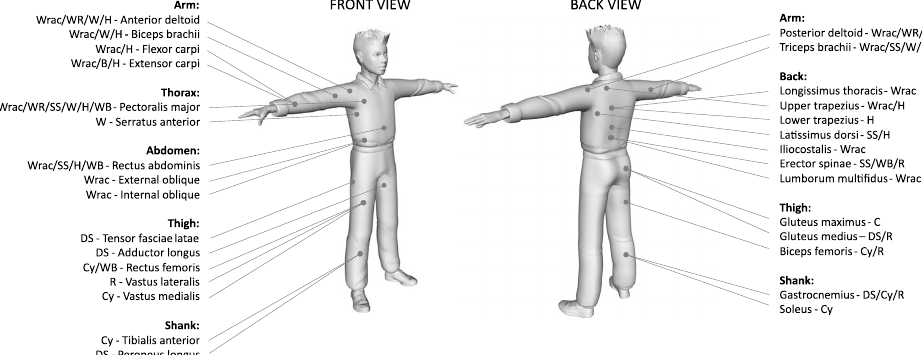
Figure 5. Positioning of EMG sensors with the specific muscle and related sport. Wrac = Wheelchair racing [47,53,54,67]; WR = Wheelchair rugby [51]; WB = Wheelchair basketball [71]; DS = Downhill skiing [74]; Cy = Cycling [52]; B = Boccia [55]; SS = Sit-skiing [56]; W = Paralympic weightlifting